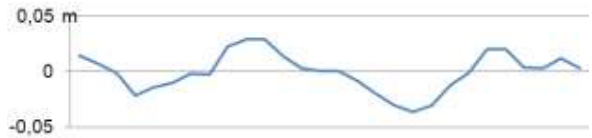
Figure 14. Averaged Pleiades y-parallax over 8km, north-south